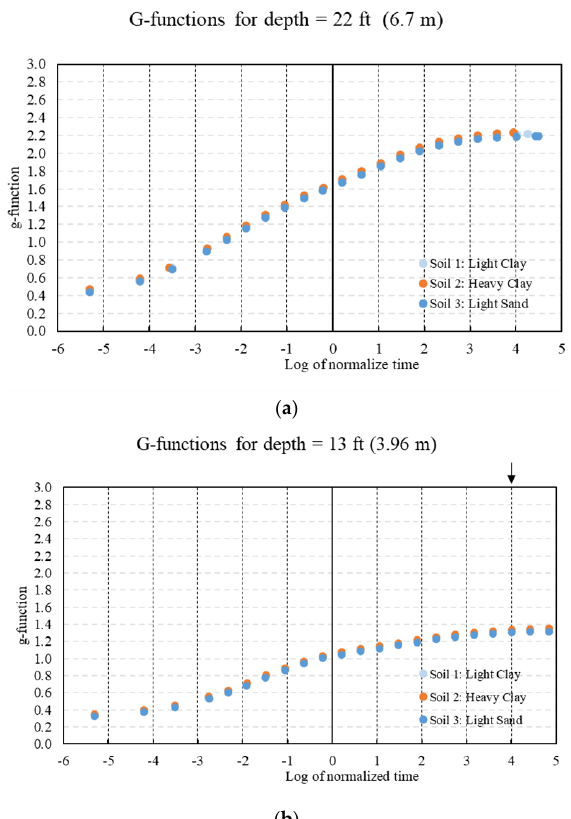
Figure 5. G-function coefficients for various soil types specific to S-GHSP with ( a ) 6.7 m (22 ft) and ( b ) 3.96 m (13 ft) deep boreholes. ( b ) 3.96 m (13 ft) deep